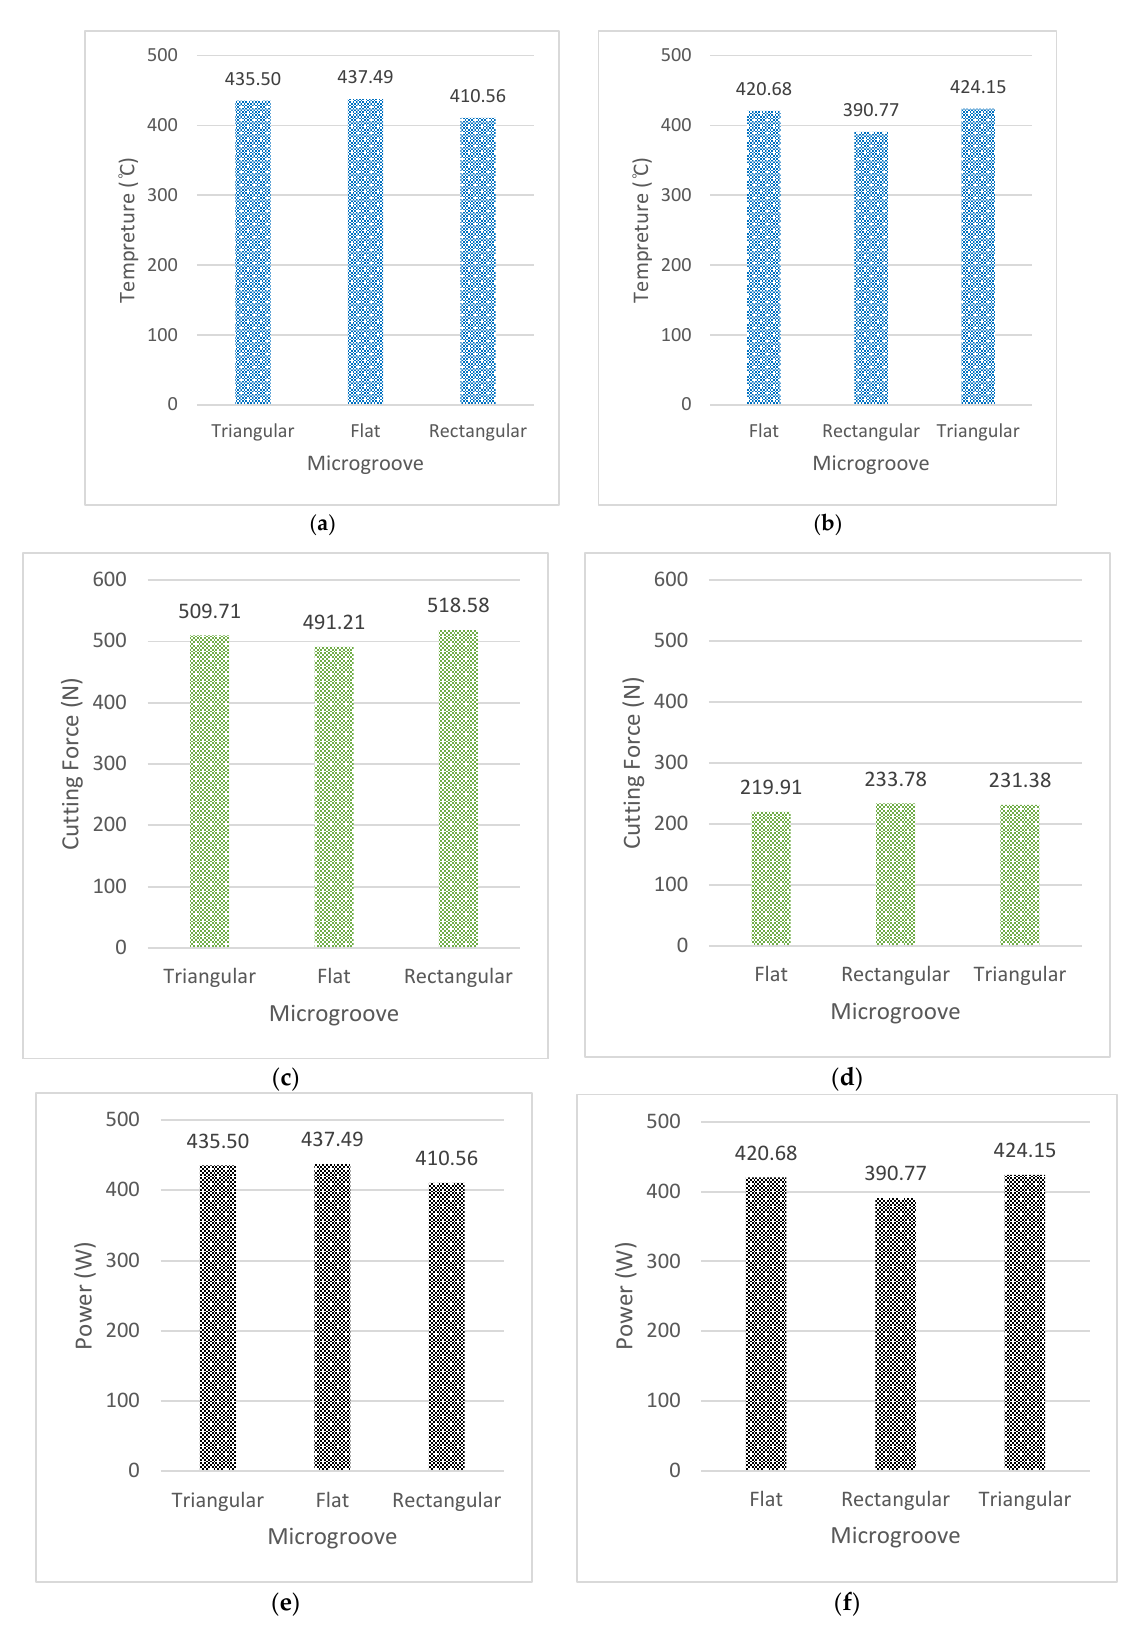
Figure 12. At cutting speed of 75 m/min: ( a ) cutting temperature at f = 0.3 mm/rev, ( b ) cutting temperature at f = 0.1 mm/rev, ( c ) cutting force ( Fx ) at f = 0.3 mm/rev, ( d ) cutting force ( Fx ) at f = 0.1 mm/rev, ( e ) cutting power at f = 0.3 mm/rev, ( f ) cutting power at f = 0.1 mm/rev.